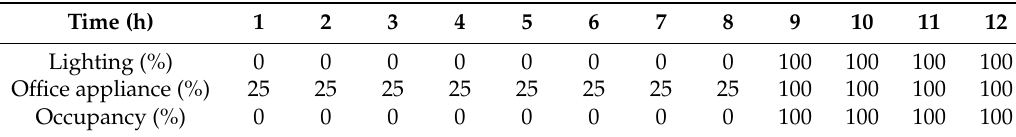
Table 5. Ratio of internal heat